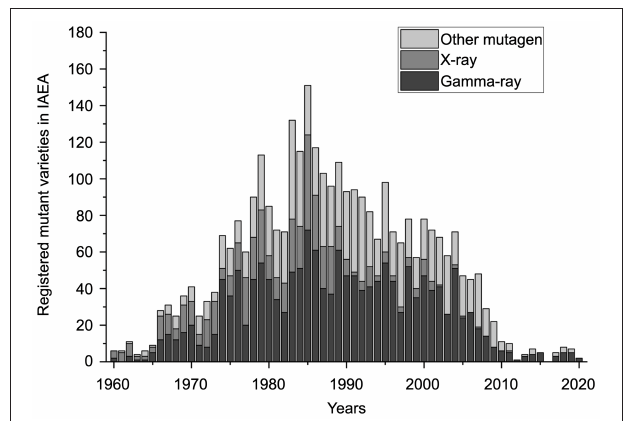
FIGURE 1 | Numbers of mutant varieties registered in IAEA during 1960–2020 (data from IAEA Mutant Variety Database).